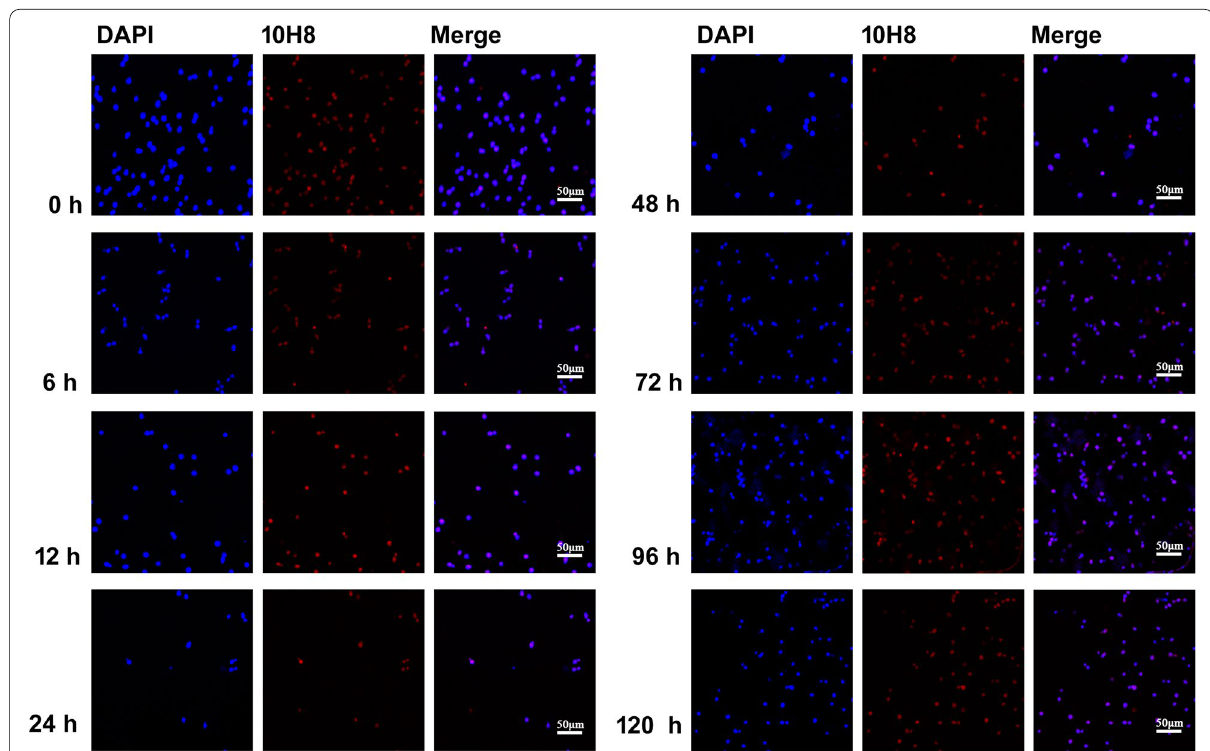
Fig. 5 Confocal microscopy analysis of 10H8-stained blastospores of Candida albicans at different culture time points. Red: 10H8 stained CaEno; Blue: DAPI; Merge is CaEno with DAPI